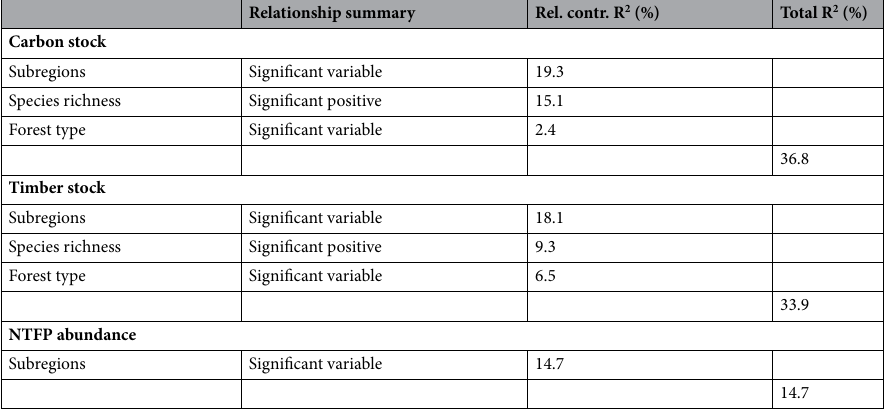
Table 1. Summary of optimized multiple linear models of carbon stock, timber stock and NTFP abundance predicted by species richness and environmental covariables across the Guiana Shield dataset (n = 151 1-ha plots). Originally included predictors were species richness, forest type, and subregion. For each retained predictor, a summary of the relationship and the relative contribution to total model R 2 (%) is given. NTFP abundance = abundance of species that produce non-timber forest products. Model details are included in Table